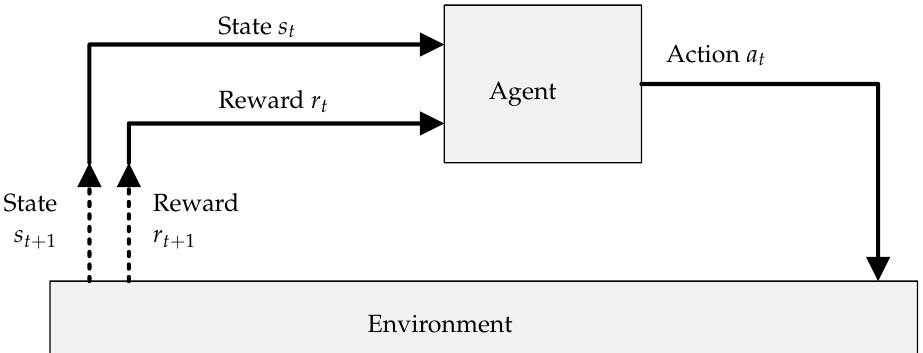
Figure 1. Simplified RL agent